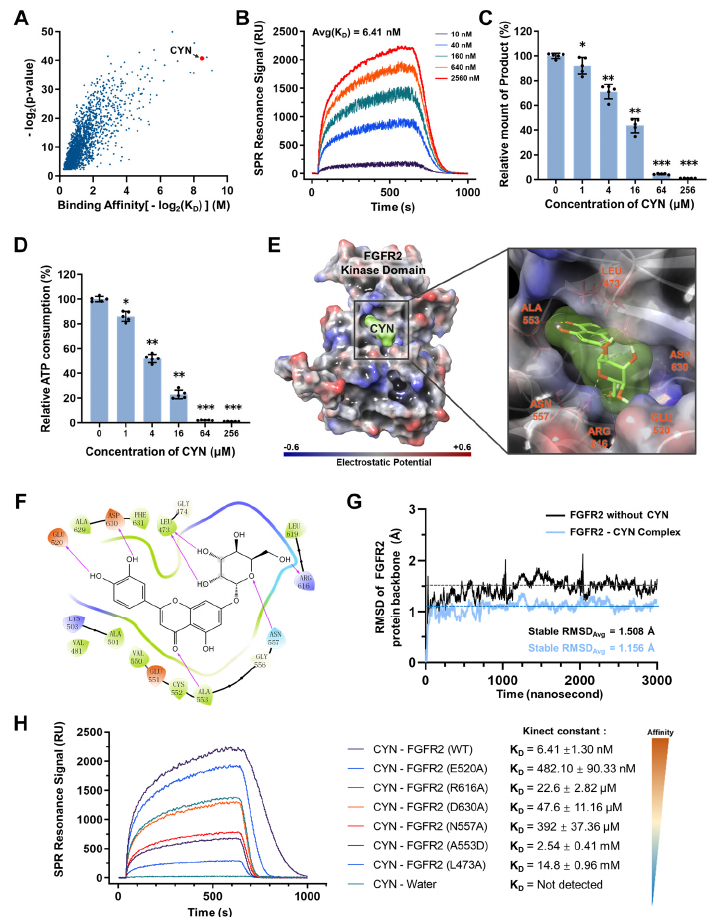
Figure 3. CYN blocks the activity of FGFR2. ( A ) A total of 2081 natural compounds were screened through high-throughput affinity analysis chips, resulting in the identification of compounds capable of binding to the FGFR2 kinase domain. The affinity and p -value of each compound were represented, and the candidate compound CYN was located in the high-affinity region. ( B ) The binding signal of FGFR2 and CYN was analyzed using surface plasmon resonance (SPR) technology at five different concentrations, and the affinity constant K D was calculated by fitting the curve algorithm. ( C ) An in vitro FGFR2 catalytic system was established, and the kinase activity was compared by measuring the phosphorylation product generation and ( D ) ATP consumption during the catalytic process. A series of concentration gradients were set up to evaluate the correlation between the inhibitory effect of CYN and its concentration. ( E ) Computational docking was utilized to predict the binding site of CYN on FGFR2. The surface charges on the model are depicted in blue (negative) to red (positive), and the appearance of the compound CYN is represented in green. Noncovalent amino acids that provide binding for the compound are marked in red on the right figure. ( F ) The diagram depicts the binding of the CYN and FGFR2 amino acid residues. ( G ) Molecular dynamics (MD)simulations were conducted to compare the stability of FGFR2 protein and FGFR2-CYN complex in aqueous environments. The mean value of the root-mean-square deviation (RMSD)at the plateau period is marked by a dotted line. ( H ) SPR was used to measure the affinity between the CYN and FGFR2 proteins with single-point mutations. The affinity is ranked from strong to weak in the legend, and the right-side values represent the corresponding K D values.